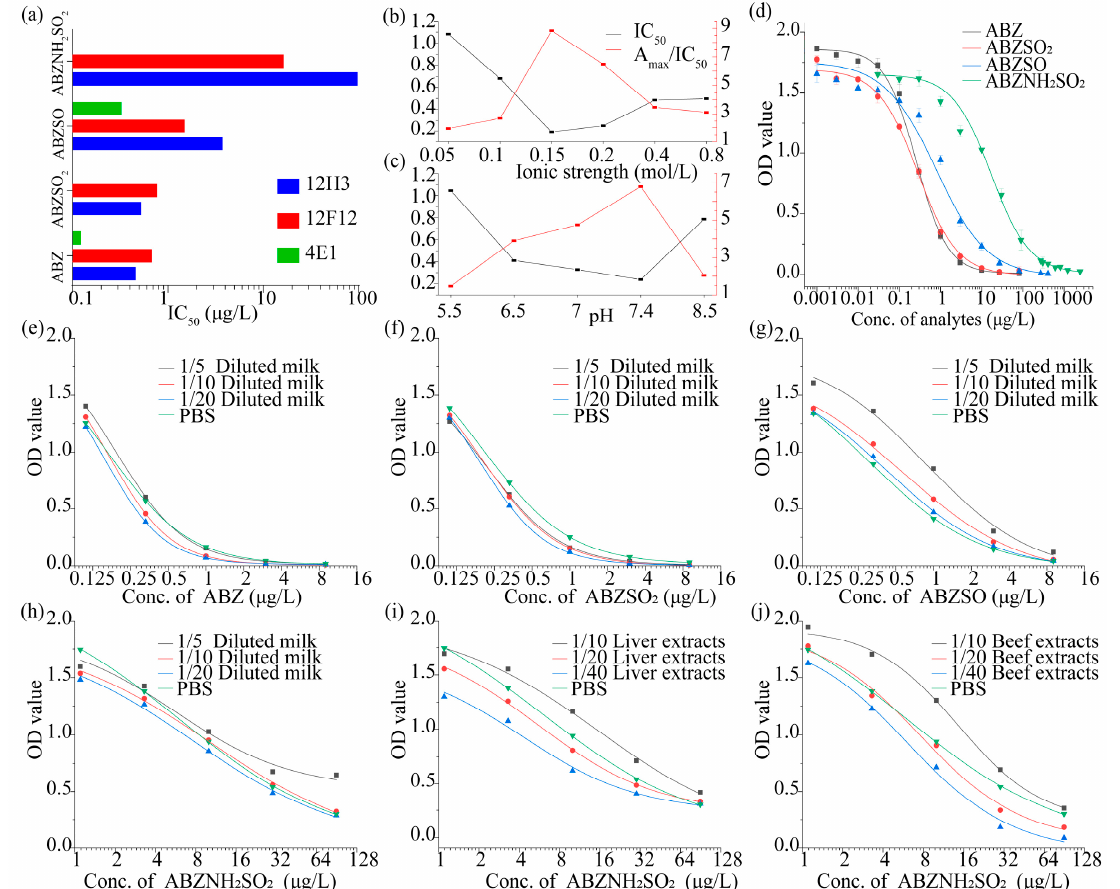
Figure 2. Optimization of ic-ELISA. The IC 50 was calculated when the A max (Optical density (OD) value of negative control) ranged from 1.0 to 2.0. ( a ) Screening of Mab. Each Mab was estimated using four ABZs separately. The effect of ( b ) pH value and ( c ) ionic strength in the ic-ELISA were evaluated using Mab 12F12 and ABZ. ( d ) Standard curves of ic-ELISA for ABZs. ( e – j ) the calibration curves of the ic-ELISA for ( e ) ABZ, ( f ) ABZSO 2 , ( g ) ABZSO, ( h ) ABZNH 2 SO 2 in phosphate buffer solution (PBS) and milk, and of ABZNH 2 SO 2 in extracted ( i ) bovine liver and ( j ) beef. Each value represents the average of three independent replicates.